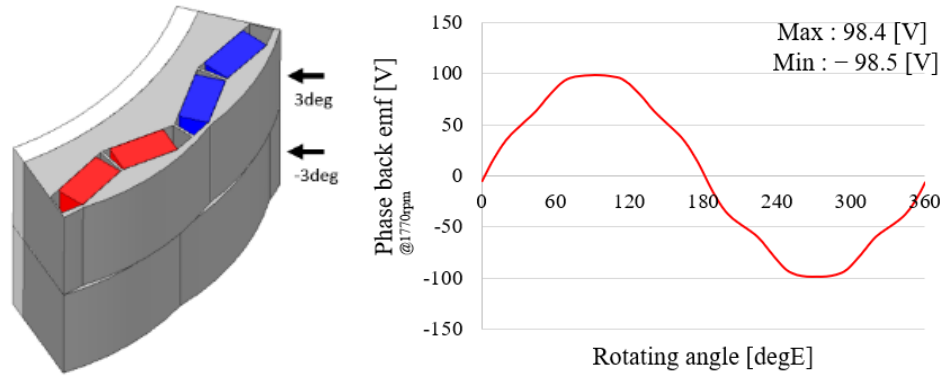
Figure 10. Two-stage skew tapering model and back emf: ( a ) two-stage skew tapering; ( b ) back